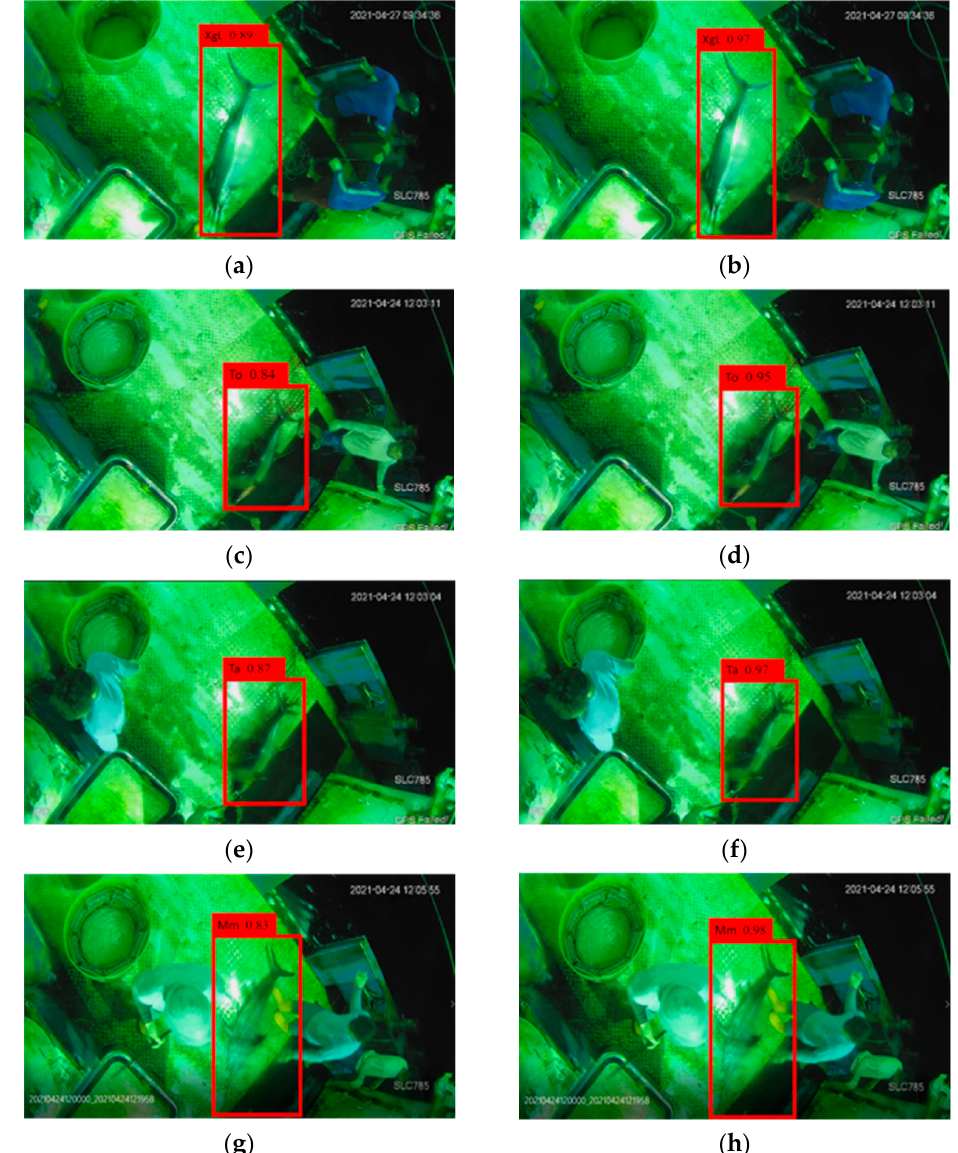
Figure 6. Comparison of test results. ( a , c , e , g ), respectively, represent detection result images by original YOLOv3, and ( b , d , f , h ) are the detection results by Tuna-YOLO.